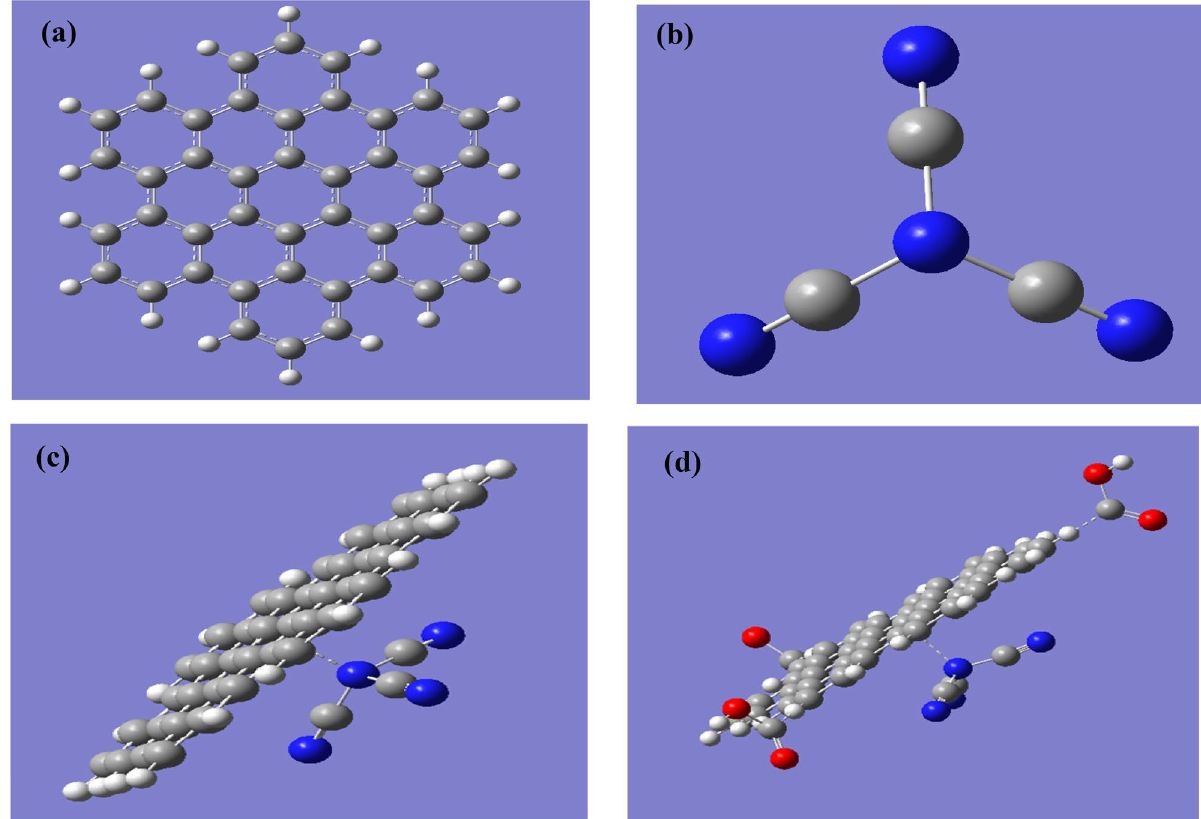
Figure 3. Optimized model molecules ( a ) Graphene quantum dots GQDs; ( b ) C3N4; ( c ) C3N4/GQDs and ( d ) C3N4/GQDs.3COOH.